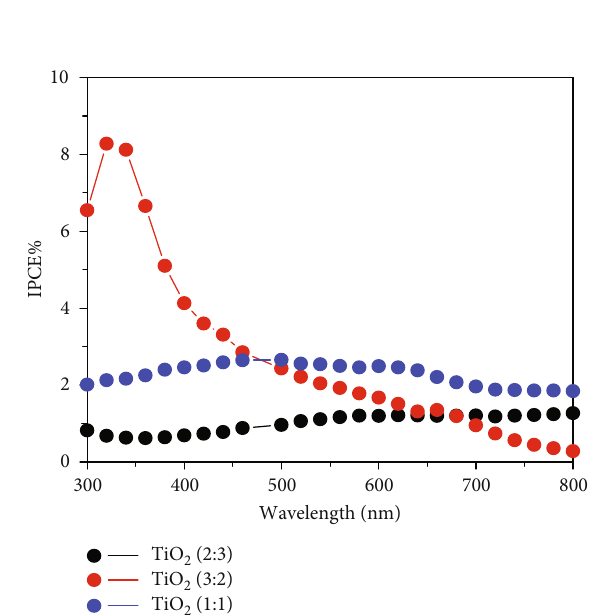
Figure 13: IPCE% spectra of DSSCs based on TiO (b) 1 :1, and (c) 3 :2 ratios using root of Knipho fi a schemperi as a light